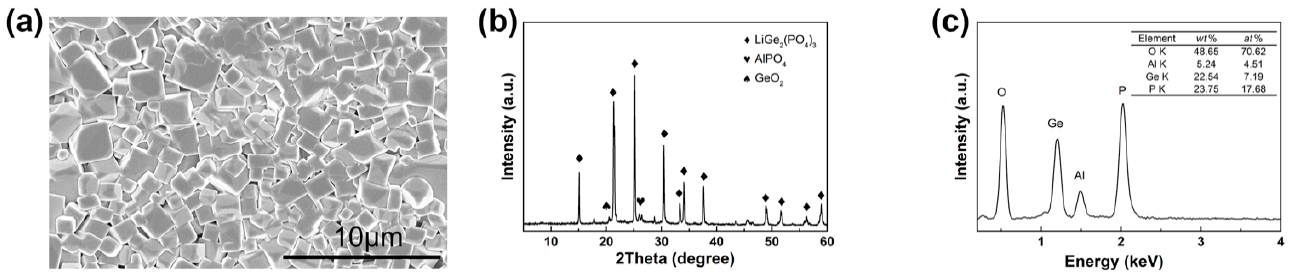
Figure 1. ( a ) SEM image, ( b ) XRD pattern and ( c ) EDS spectrum with the table showing the ratio of elements of self-made LAGP.